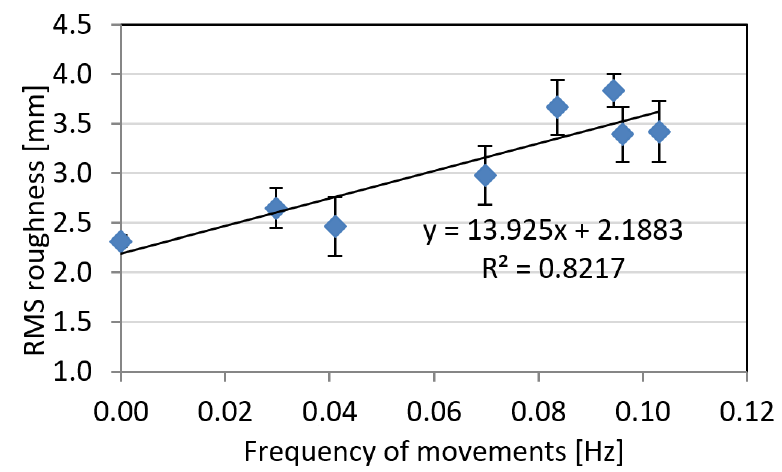
Figure 5. RMS roughness as a function of frequency of movements. Error bars represent standard deviation on three different reconstructions.